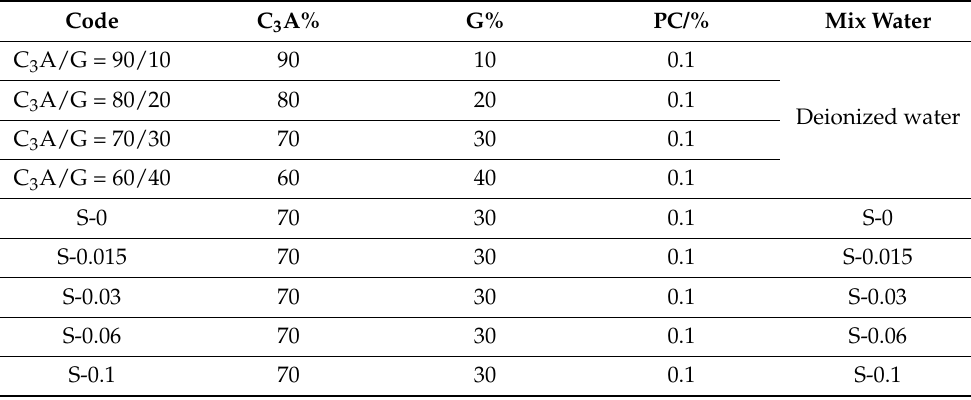
Table 2. Mixture proportions and codes for C 3 A hydration at 20 min.